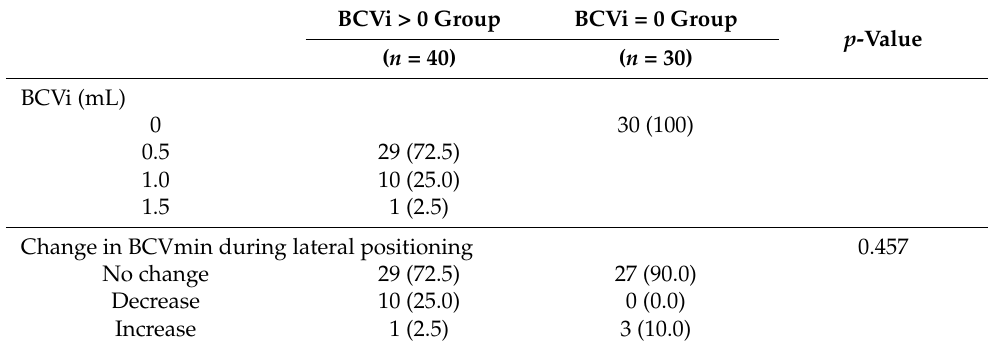
Table 3. Outcomes related to bronchial cuff volume.